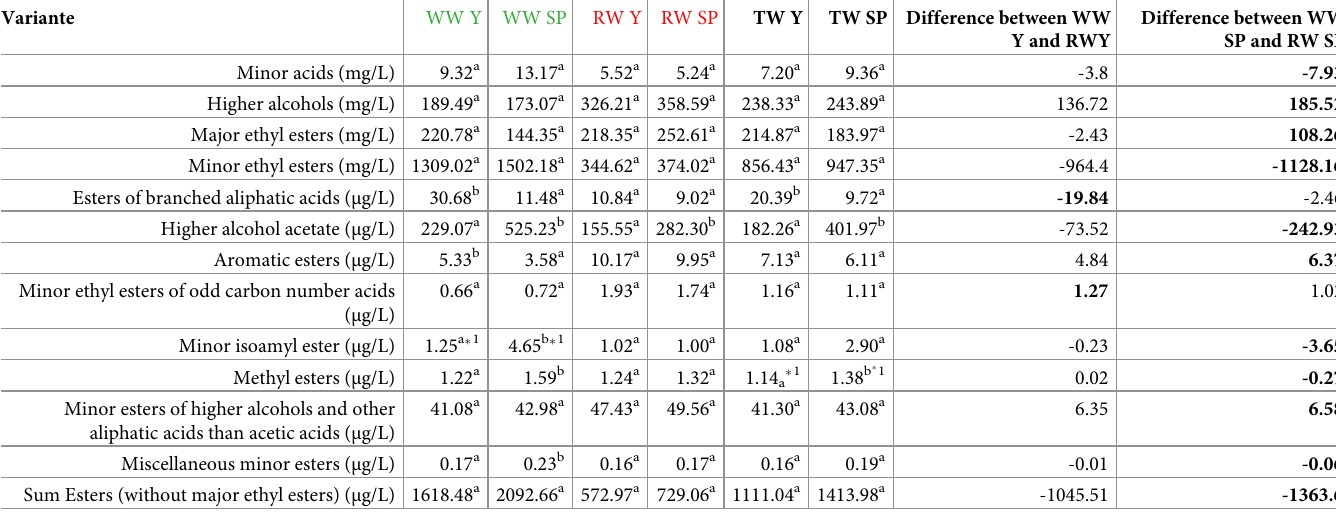
Table 4. Sum concentration for white. red. total wine variants and differences between white and red variants of the different aroma groups.